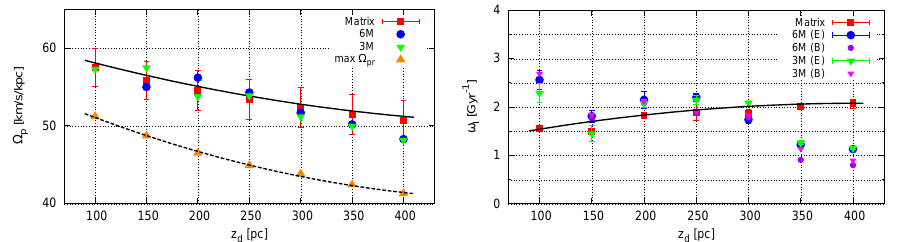
Fig. 4. Comparison of characteristics of eigenmodes for different disk vertical scale lengths z d obtained in the matrix method and N -body N d = 6M and 3M runs. Left-hand panel: The pattern speeds. The upper and lower limits of the red error bars show the pattern speeds of modes with the largest growth rates. The orange upward triangles show the maxima of the precession curves. The black solid and dashed lines are smooth fits. Right-hand panel: The growth rates. The upper and lower limits of the red error bars show two maximum growth